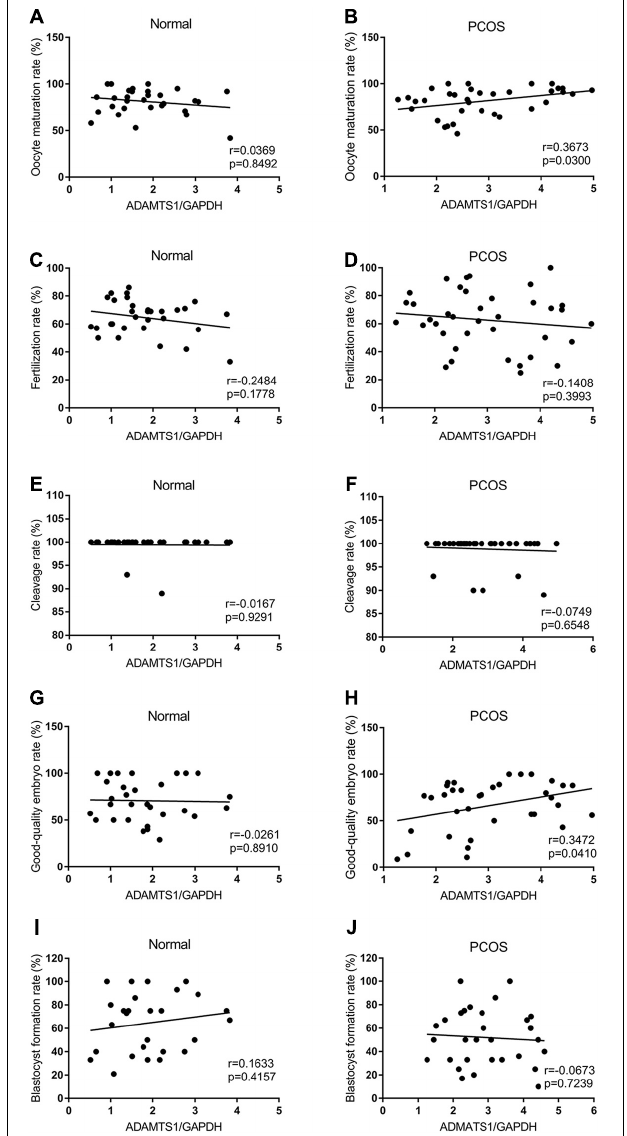
FIGURE 4 | Scatter plots were used to depicting the correlation between the IVF-ET laboratory indicators including oocyte maturation rate (A,B) , fertilization rate (C,D) , cleavage rate (E,F) , good-quality embryo rate (G,H) and blastocyst formation rate (I,J) and the expression of ADAMTS1 in granulosa cells from control and PCOS patients. Statistical analysis of the data was performed using the Spearman